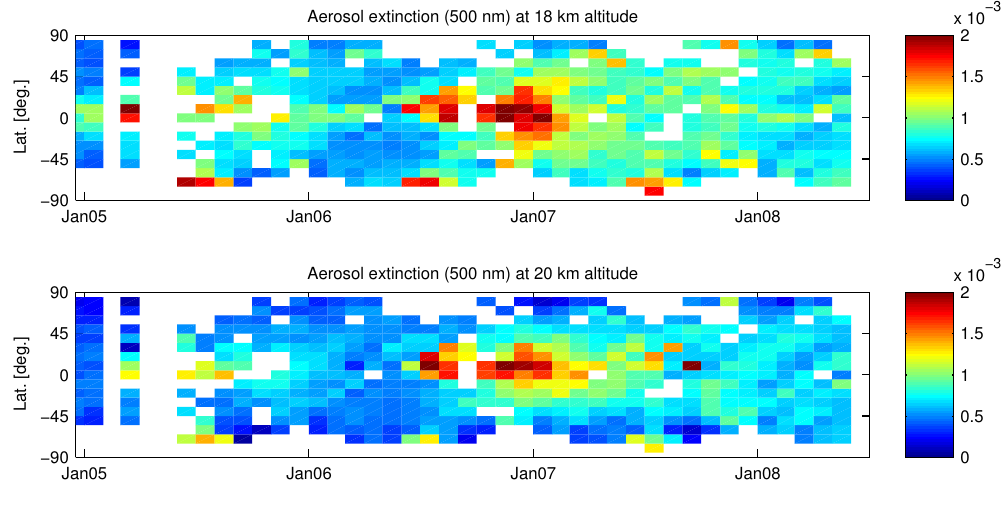
Fig. 7. Checkerboard plots showing the median of binned 500 nm aerosol extinction data as function of latitude and time, at an altitude of 18 km (upper panel) and 20 km (lower panel). Notice the elevated values after early 2005, and after the end of May 2006. The global spreading is clearly visible in the latter case.